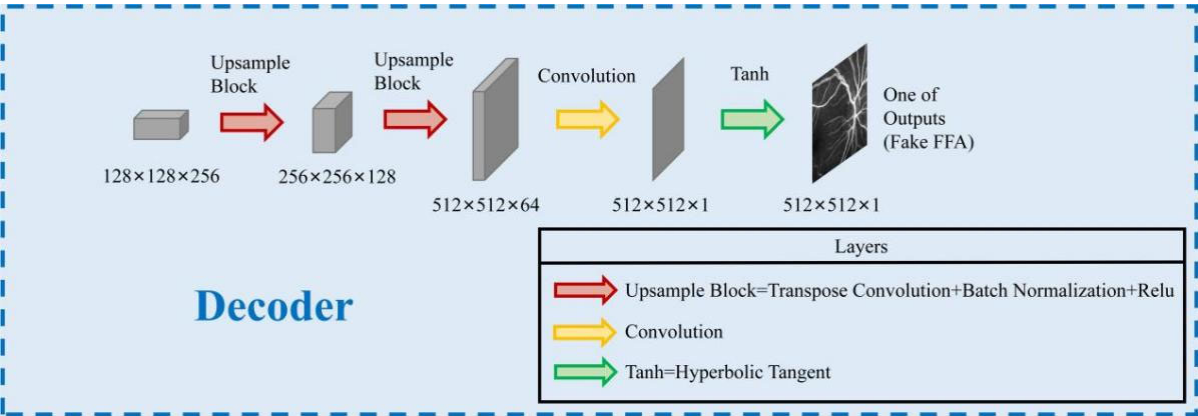
Figure 4. Network architecture of our decoder.